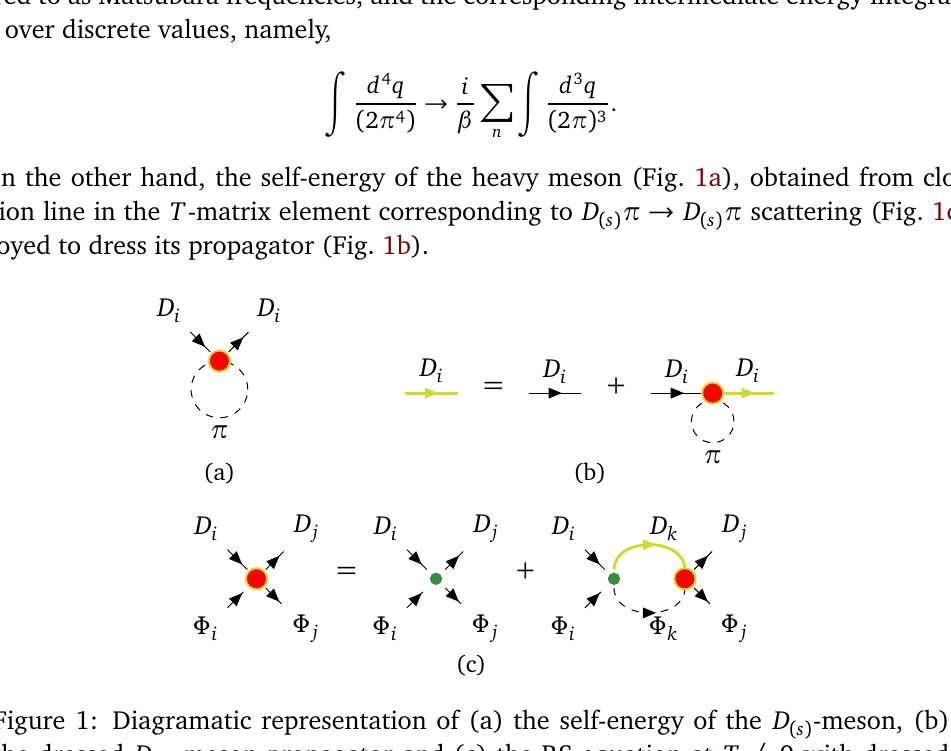
Figure 1: Diagramatic representation of (a) the self-energy of the D ( the dressed D ( -meson propagator and (c) the BS equation at T (cid:54) = 0 with dressed s ) propagators in the